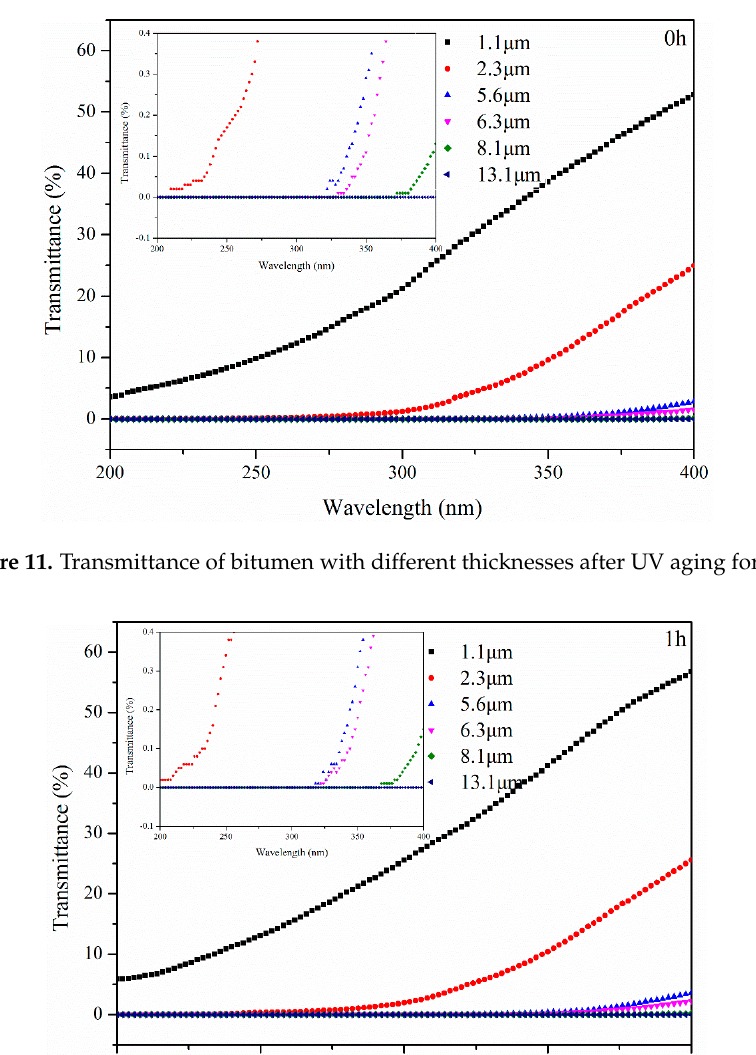
Figure 13. Transmittance of bitumen with different thickness after UV aging for 5 h. The transmittance of bitumen with different thicknesses after UV aging for 10 h is illustrated in Figure 14. The transmittance of B further increased after UV aging. Furthermore, UV radiation from